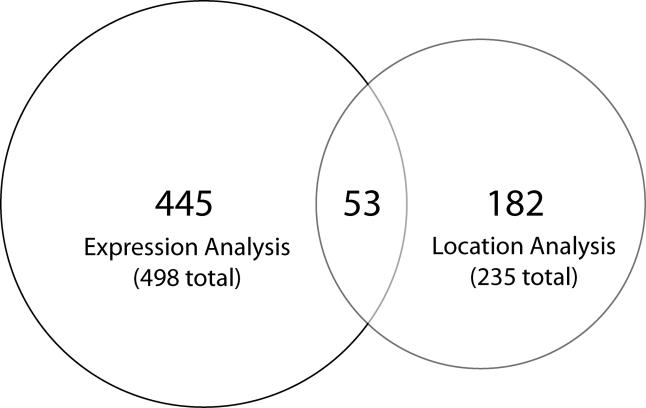
Intersection of Expression Data and Location AnalysisOf the genes common to both the cDNA microarray and the promoter microarray, 498 were differentially expressed and 235 were bound by the GR. Intersecting the two lists produced 53 genes in common. This list represents direct, functional targets of the GR in hepatocytes.